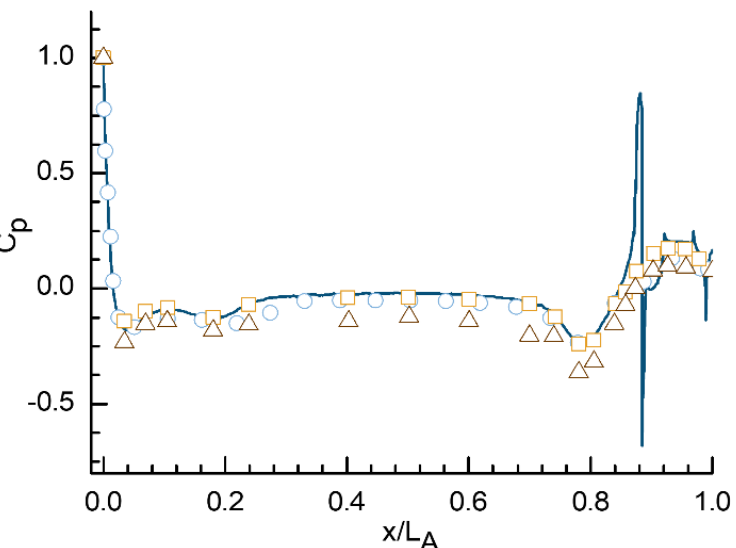
Figure 4. Pressure coefficient of SUBOFF AFF − 3. Present result: — Plane a on the side of the negative